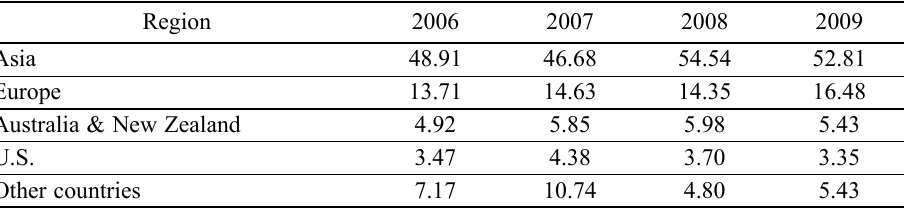
Table 4. Singapore’s OFDI by region (% share), 2006−2009